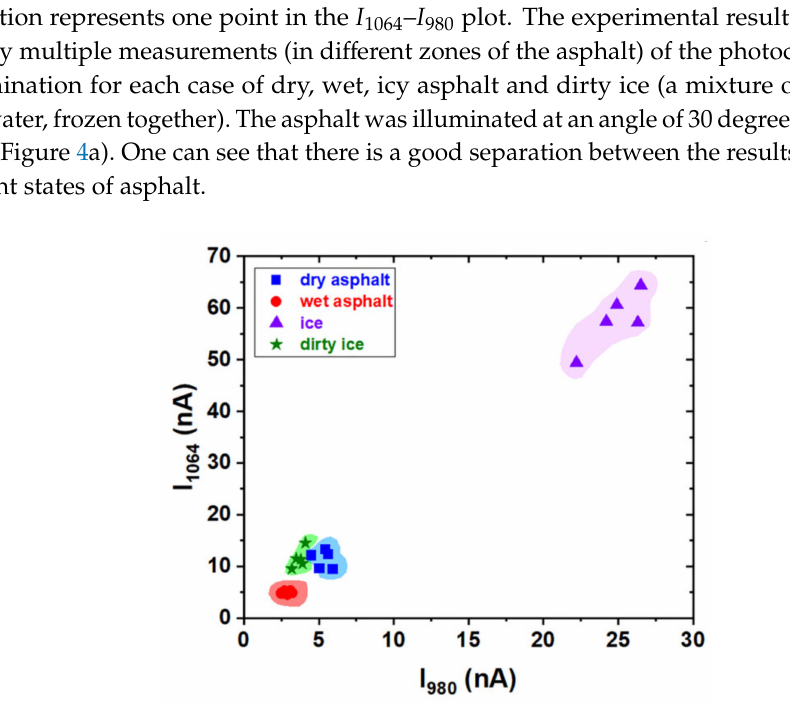
Figure 6. Experimental results obtained by multiple measurements of the photocurrent for the two laser diode illumination in the case of dry, wet, icy asphalt and dirty ice (frozen monolith of mixed asphalt powder, dust and